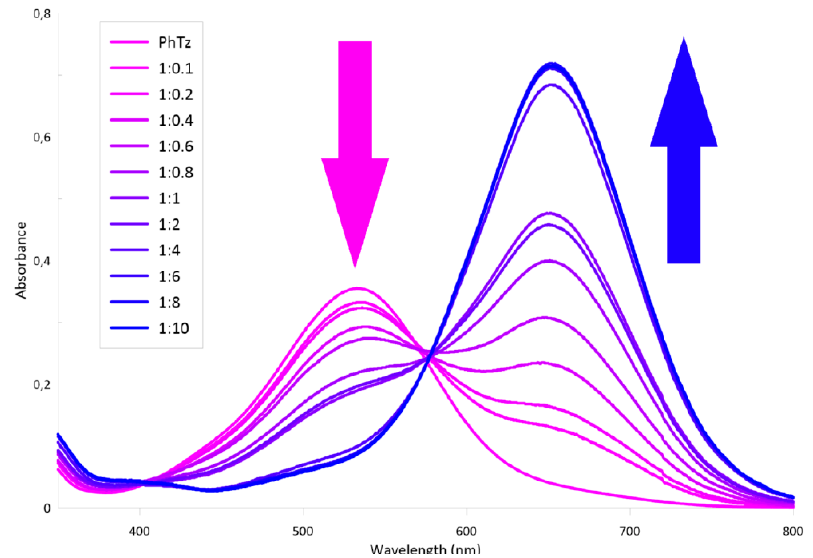
Figure 2. Titration graph of PhTz (C = 1 × 10 -5 M) with tris-pillararene 4 (C=1 × 10 -6 M–1 × 10 -4 M), in legend the corresponding to graphs concentration ratios (eq.) [ PhTz ]:[ 4 ] are listed.